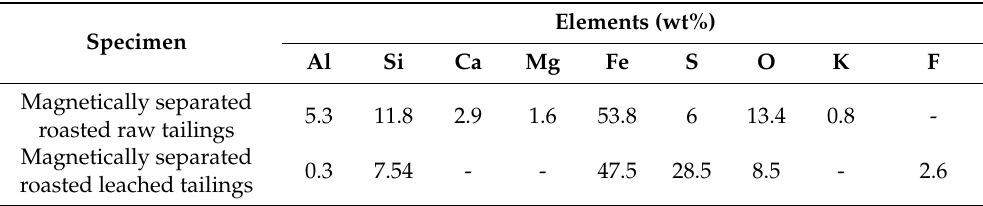
Table 6. The semi-quantitative average elemental compositions of magnetic separated specimens from EDS